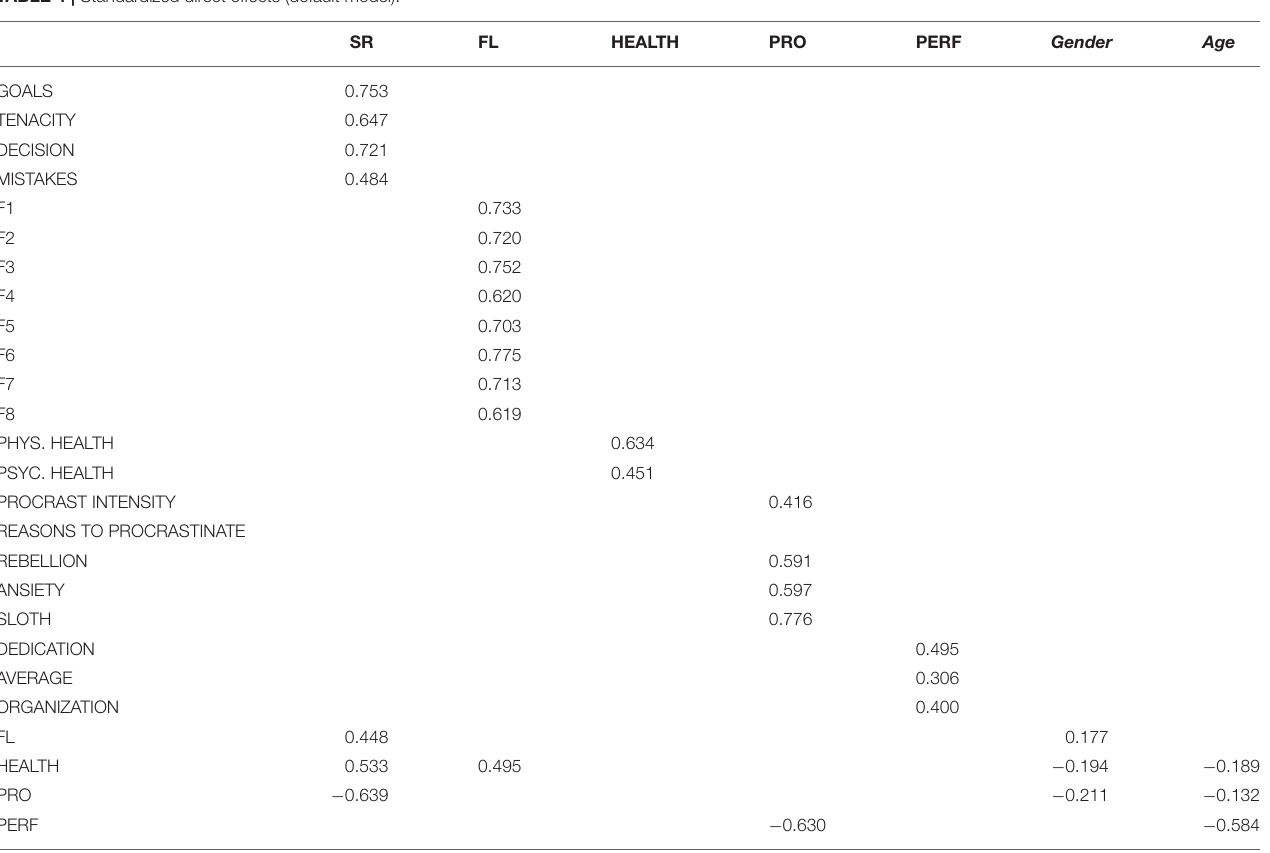
TABLE 4 | Standardized direct effects (default